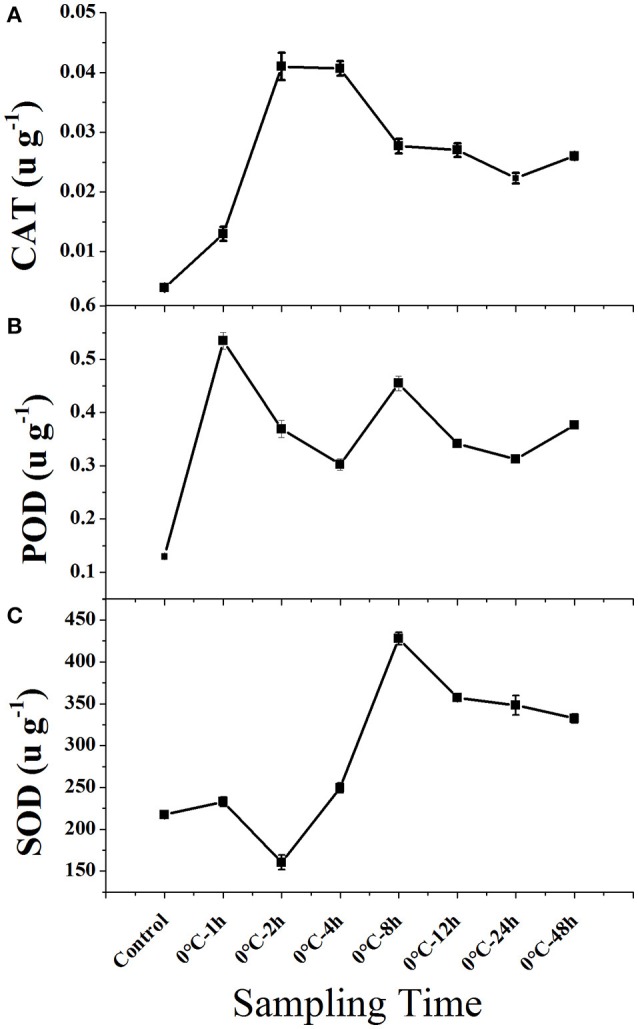
Enzyme activity of CAT, POD, and CAT in leaf tissues of Taxus chinensis grown under normal and cold stress conditions. (A) Hydroperoxidase (CAT), (B) Peroxidase (POD), and (C) Superoxide Dismutase (SOD). Leaf tissues were sampled from plants grown under normal conditions and from plants that were subjected to 0°C for 1, 2, 4, 8, 12, 24, and 48 h. Results are means and SD for three replicates.